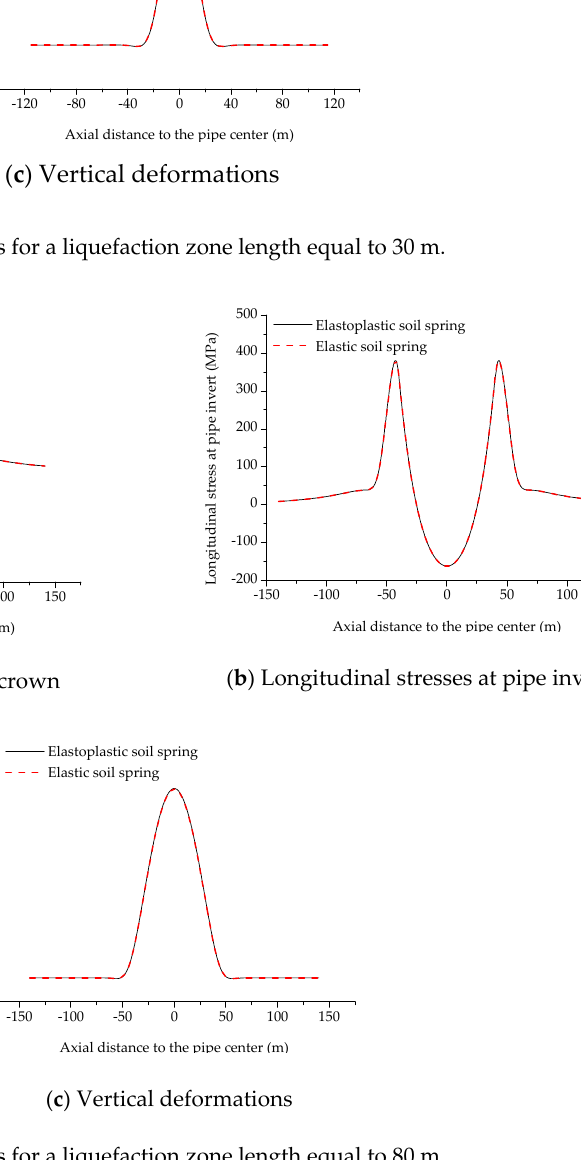
Figure 9. Results for a liquefaction zone length equal to 80 m.